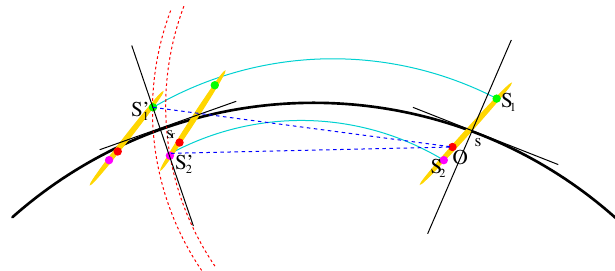
FIG. 1. (Color) Illustration of the interaction of the source and S 0 at path length s with the test particle O at particles S 0 r 1 2 (cid:1) S path length s for a tilted bunch. The retardation requires d S 0 1 1 (cid:1) (cid:3) v (cid:3) v =c (cid:5) S 0 O and d S 0 S =c (cid:5) S 0 O (may not be seen from draw- 1 2 2 1 2 2 ing which is not to scale). The source particles S 0 and S 0 are at 1 2 the intersections of s (cid:1) s with the past light cones (dashed red r arcs) of the test particle O at (cid:3) x; z; s (cid:5) , with the retarded velocities and v , of v 1 2